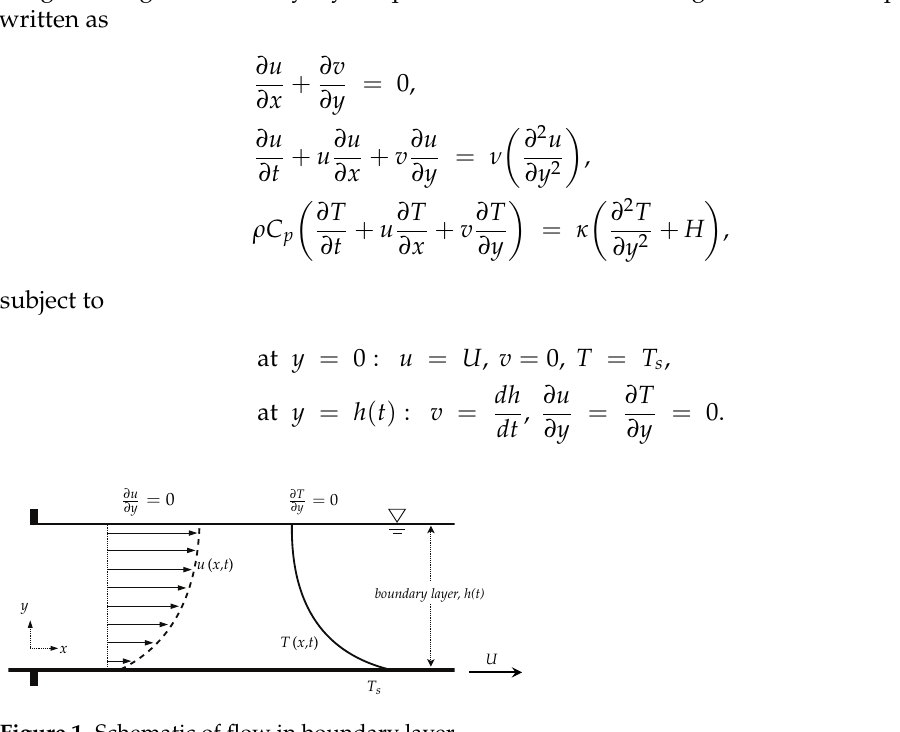
Figure 1. Schematic of flow in boundary